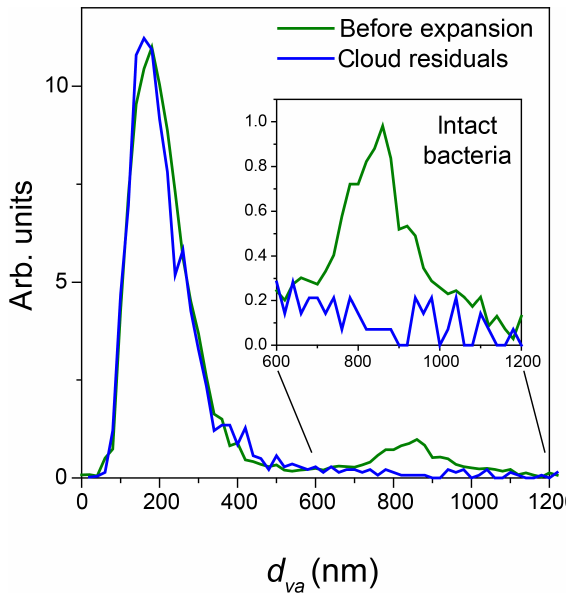
Figure 5. Normalized miniSPLAT-measured d va size distributions of Pseudomonas syringae particles in the AIDA chamber before Ex- pansion 1 (green) and of cloud residuals transmitted through the PCVI during the expansion (blue). The inset presents in expanded scale the size distributions of the intact bacteria, showing that cloud residuals do not exhibit the distinct peak for intact